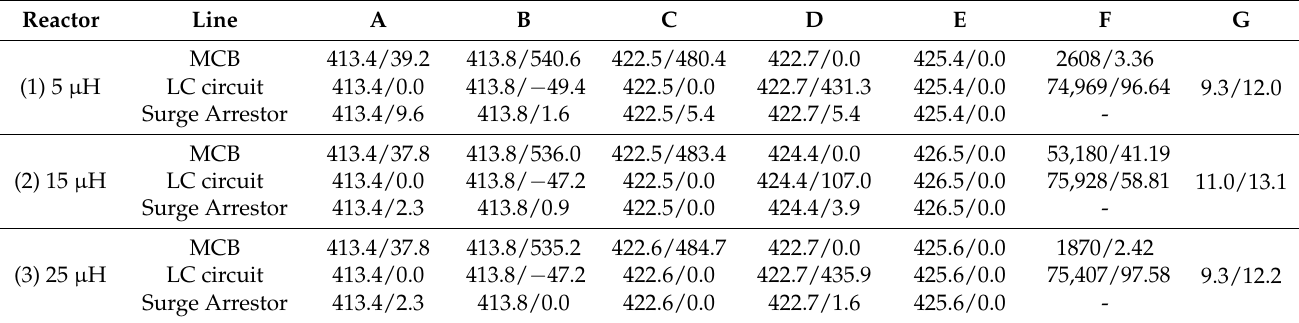
Table 1. Experimental result table of operating characteristics of DC circuit breaker to which the Capacitor variable are applied.